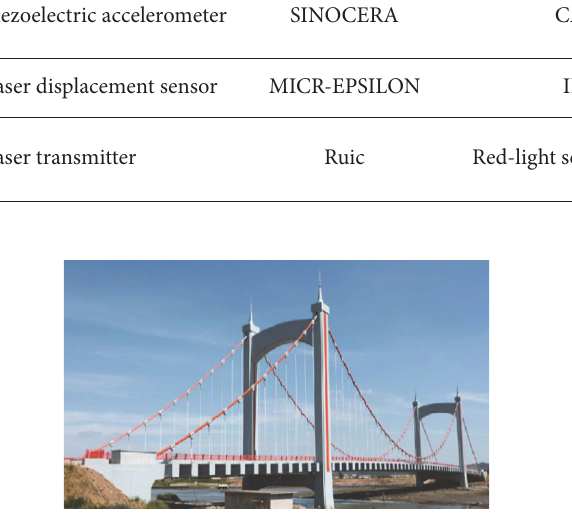
Figure 9: Zhuanghe Construction Bridge.